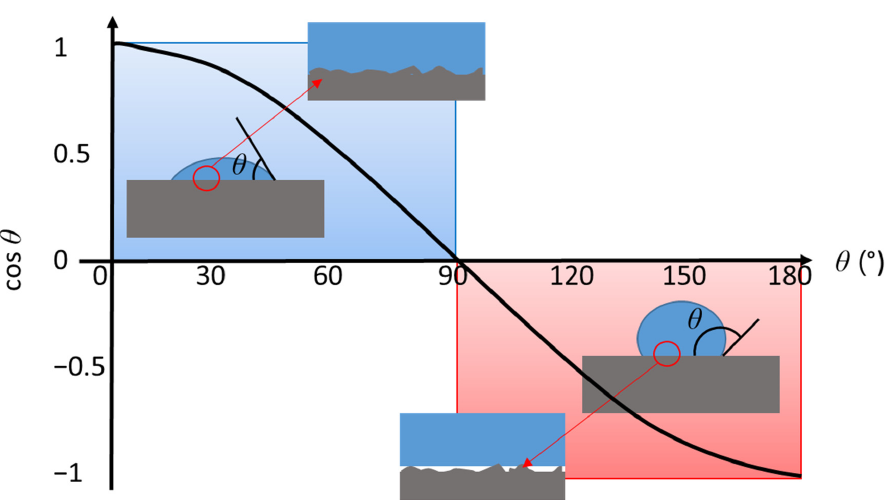
Figure 4. Schematic illustration of the increase in contact angle θ between hydrophilic and hydrophobic surfaces: the inserts show the difference between the cases when there is also a surface roughness present, whereby the surface becomes liquid filled in the case of perfect wetting versus the retention of air in the surface voids in the hydrophobic case.